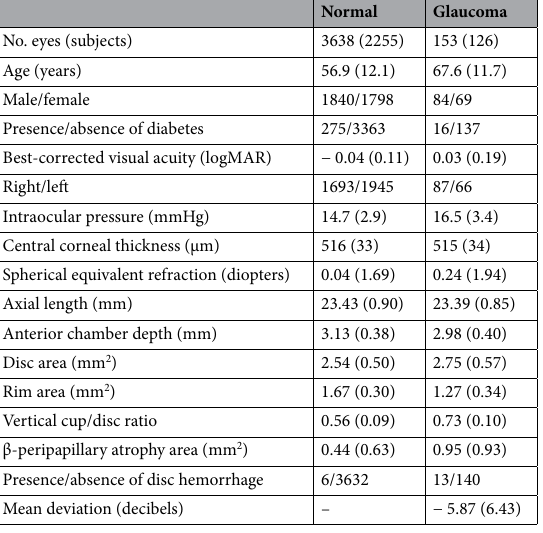
Table 4. Demographic data from 3638 normal eyes of 2255 normal subjects and 153 eyes with definite glaucoma of 126 patients with glaucoma for whom all parameters values used for analysis were available. The data are expressed as the mean (standard deviation). logMAR logarithm of the minimum angle of resolution.